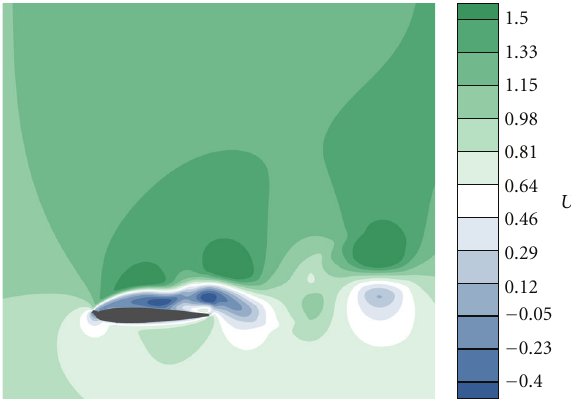
Figure 14: Established iced NACA 0012 solution at Re = 1000— U velocity